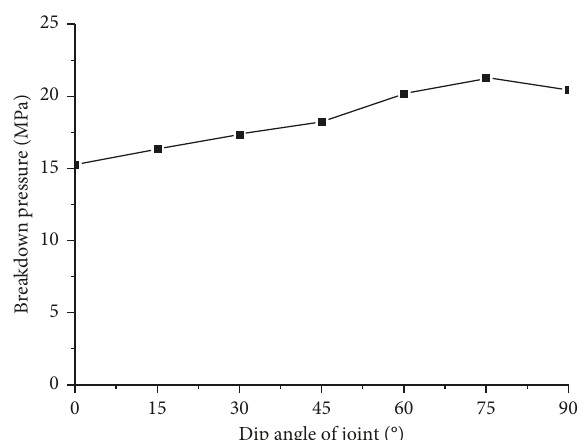
Figure 9: Breakdown pressures of dip angle